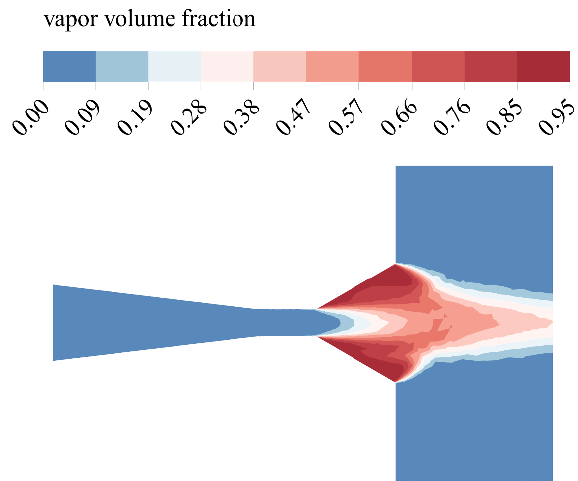
Figure 13. Vapor volume fraction variation of the angular cavitation nozzle.